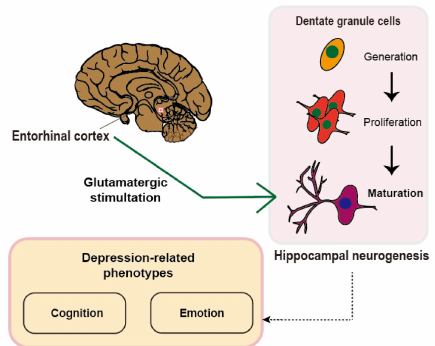
Figure 1. Hypothetical concept of the role of entorhinal cortex-regulated hippocampal neurogenesis in the manifestation of depression-related symptoms. The glutamatergic stimulation from the entorhinal cortex to the dentate gyrus of the hippocampus is illustrated. The glutamatergic stimulation regulates the maturation process of the dentate granule cells during hippocampal neurogenesis, which in turn affects cognition and